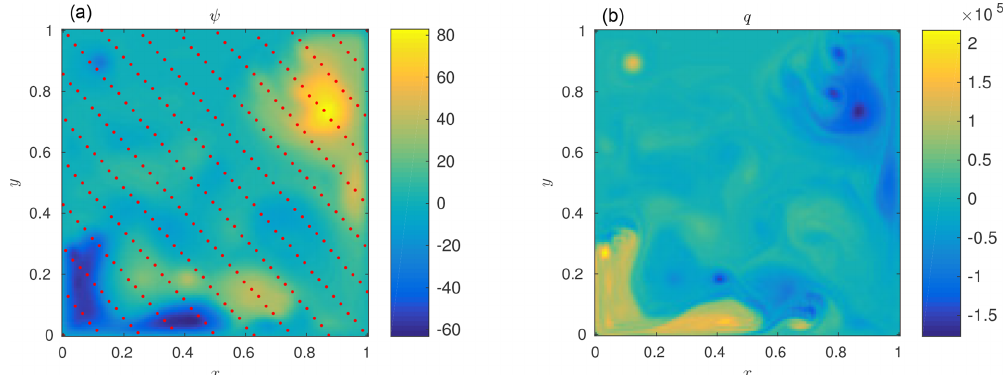
Figure 7. Quasi-geostrophic model. A typical model state of the 1.5-layer quasi-geostrophic model. (a) shows the stream function values, with the red dots representing the locations of the variables that are observed. (b) shows the corresponding vorticity.